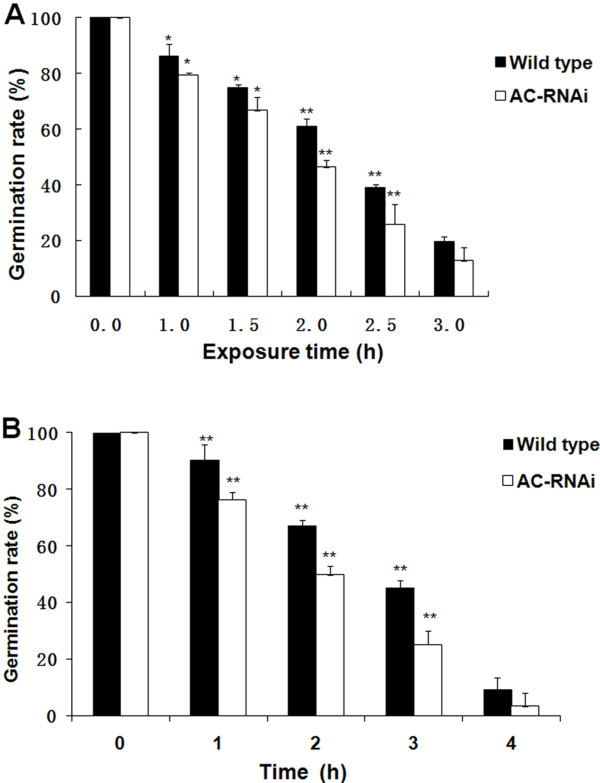
Germination rate of the M. acridum wild type and AC-RNAi mutant with wet-heat and UV-B treatments.A. Germination rate were tested after wet-heat exposure to temperature of 45°C for 0, 1.0, 1.5 2.0, 2.5 and 3.0 h. B. Germination rate after UV-radiation exposure for 0, 1, 2, 3 and 4 h. Standard deviation bars denote standard deviations for three independent experiments. *: significant difference, p <0.05; **: significant difference, p <0.01.